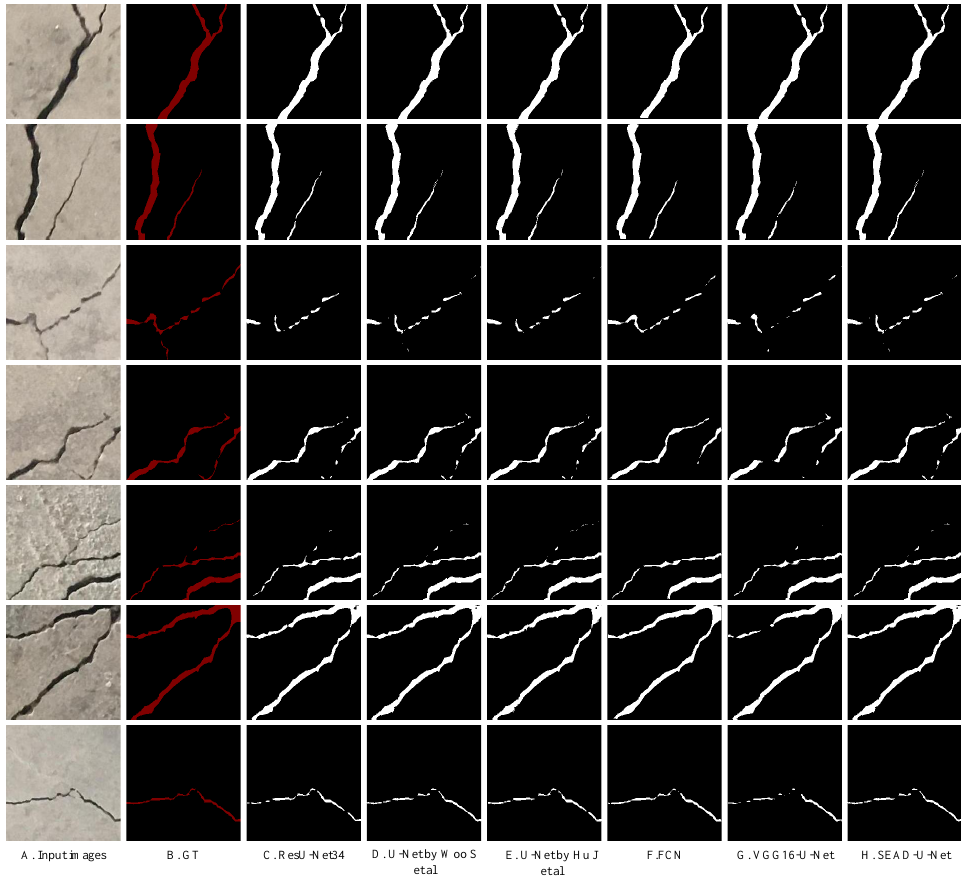
Figure 8. CCIC dataset segmentation result